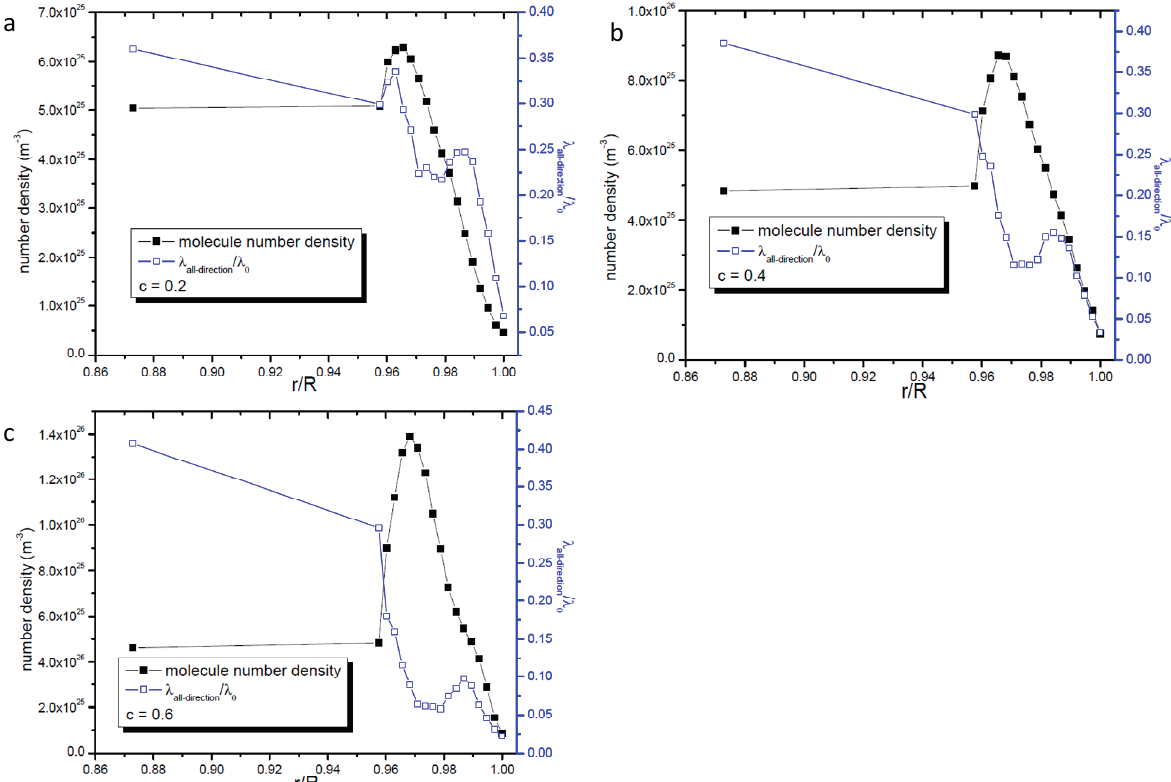
Figure 6. Profiles of gas molecular mean free path and gas number density in the zone 0.7 nm apart from the nanopore’s wall surface. ( a ) c = 0.2; ( b ) c = 0.4; and ( c ) c =